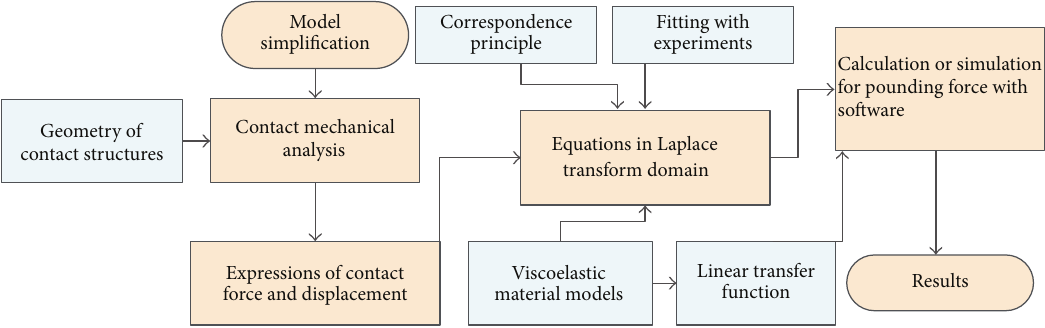
Figure 4: Sketch of the proposed pounding force analysis model.